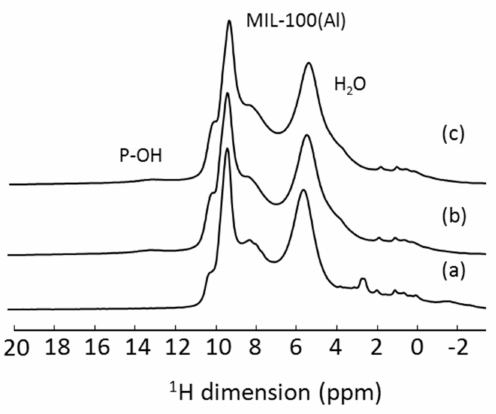
Figure 3. 1 H MAS NMR spectra of ( a ) nanoMIL-100(Al), ( b ) ATP-loaded nanoMIL-100(Al) and ( c ) CD-P coated ATP-loaded